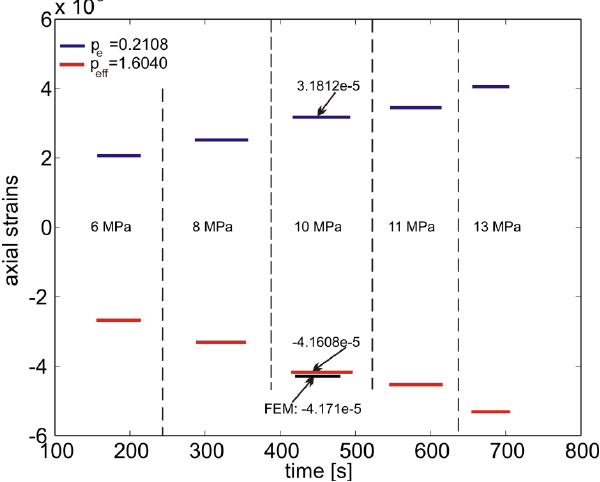
Figure 8. Unidirectional composite subjected to hydrostatic pressure: comparison between strain calculated from the wavelength measurements and Equation (4a) with 0.2108 p  . The vertical dashed lines indicate the application well as Equation (6a) with 1.6040 eff e time of each pressure step. The FE prediction for 10MPa pressure is also